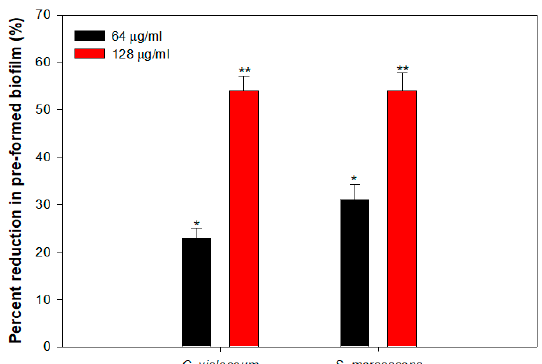
Figure 11. E ff ect of sub-MICs of ZnO@XG on preformed biofilm of C. violaceum 12472 and S. marcescens ATCC 13880. Data are represented as mean values of triplicate readings, and the bar is the standard deviation. * denotes significance at p ≤ 0.05, and ** denotes significance at p ≤